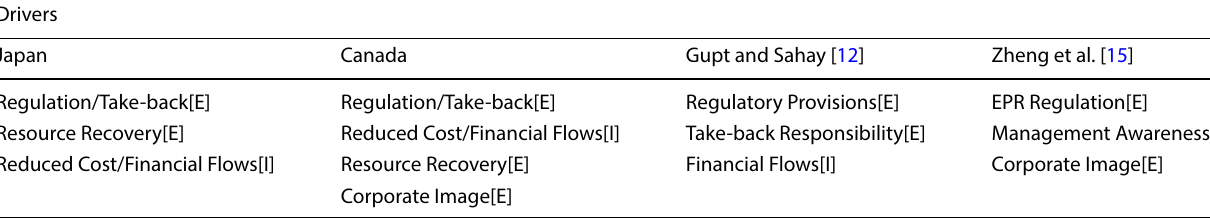
Table 8 Classification of importance of top three drivers between cases and